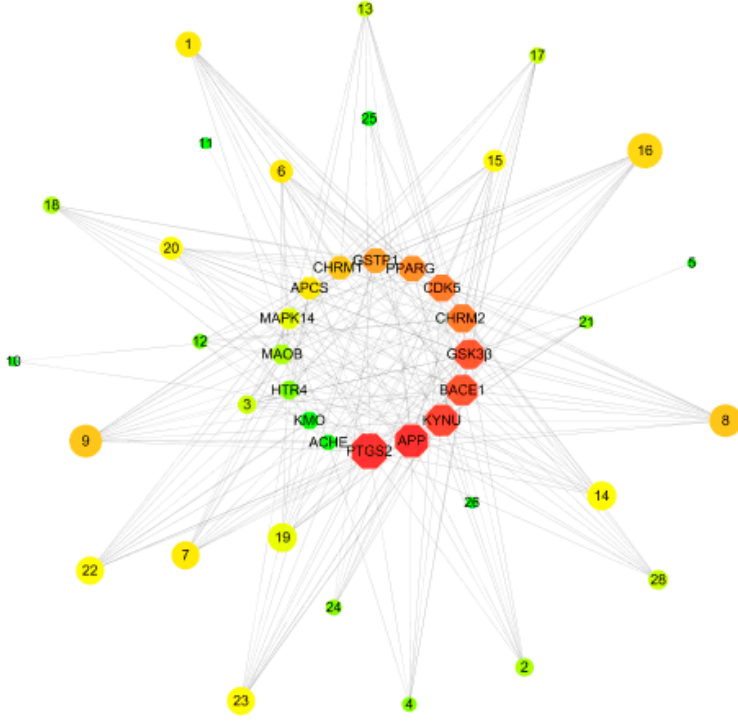
Figure 2. Compound–target network for potential inhibitors in OC. There is a positive correlation between the area of compounds and targets.